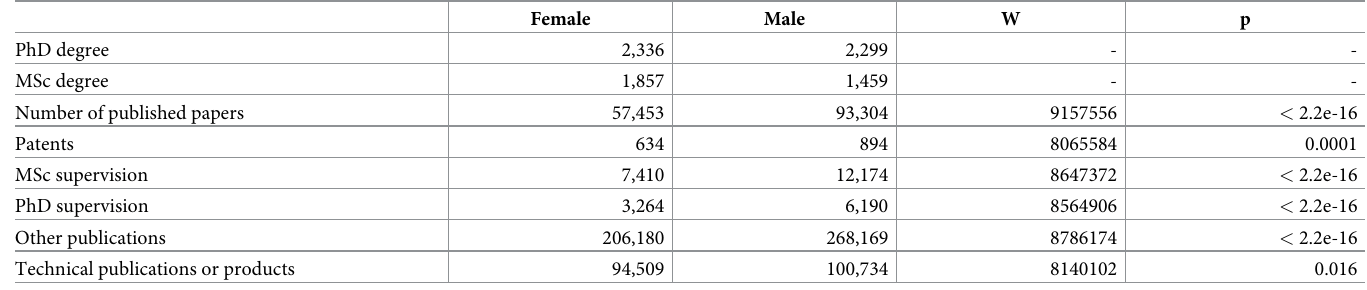
Table 1. Summary of the iAraucaria and Wilcoxon rank sum test results (W and the p value, except for Msc or PhD degree).